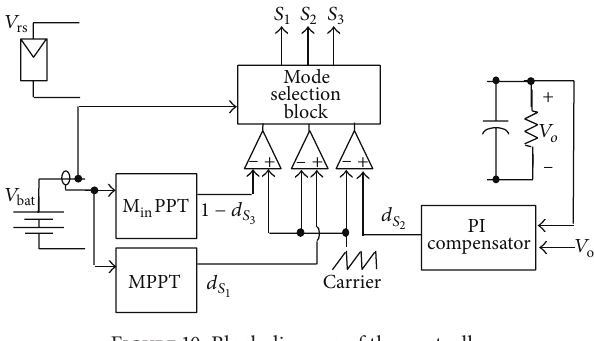
Figure 10: Block diagram of the